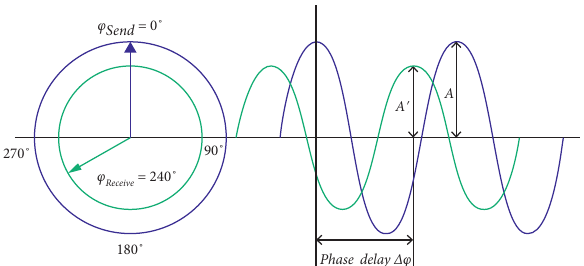
Figure 1: The continuous-wave modulation measurement method of TOF.